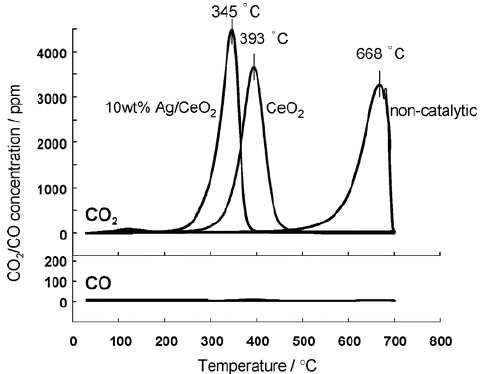
Figure 6. Effect of Ag loading on soot combustion profiles of CeO 2 . Soot/CeO 2 tight-contact mixtures with a weight ratio of 1/20 were heated in 10% O 2 /N 2 at the rate of 10 °C·min − 1 . Reproduced from Ref. [48] with the permission from the American chemical society.